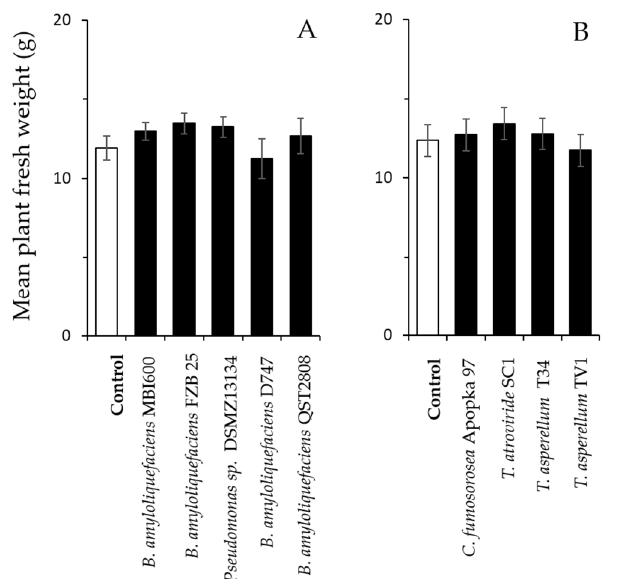
Figure 4. Effects of microbial colonization on plant growth of green peach aphid-infested peppers. Plants were inoculated at transplantation and one week later with the different bacterial ( A ) and fungal ( B ) microbes. Shown are means (± SE) of fresh weight per plant ( n = 6 per treatment) 14 days following infestation with 10 M. persicae females per plant ( t -test; p > 0.05).